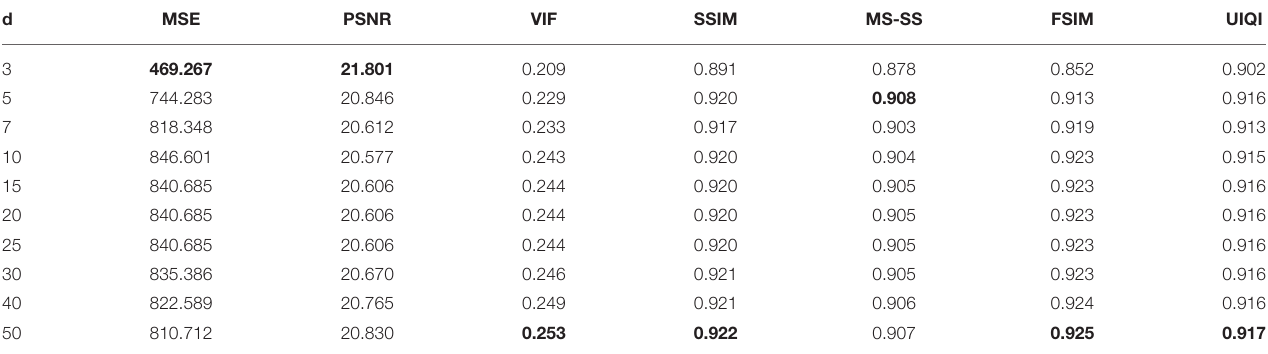
TABLE 2 | Quantitative comparison of different event frame buffer